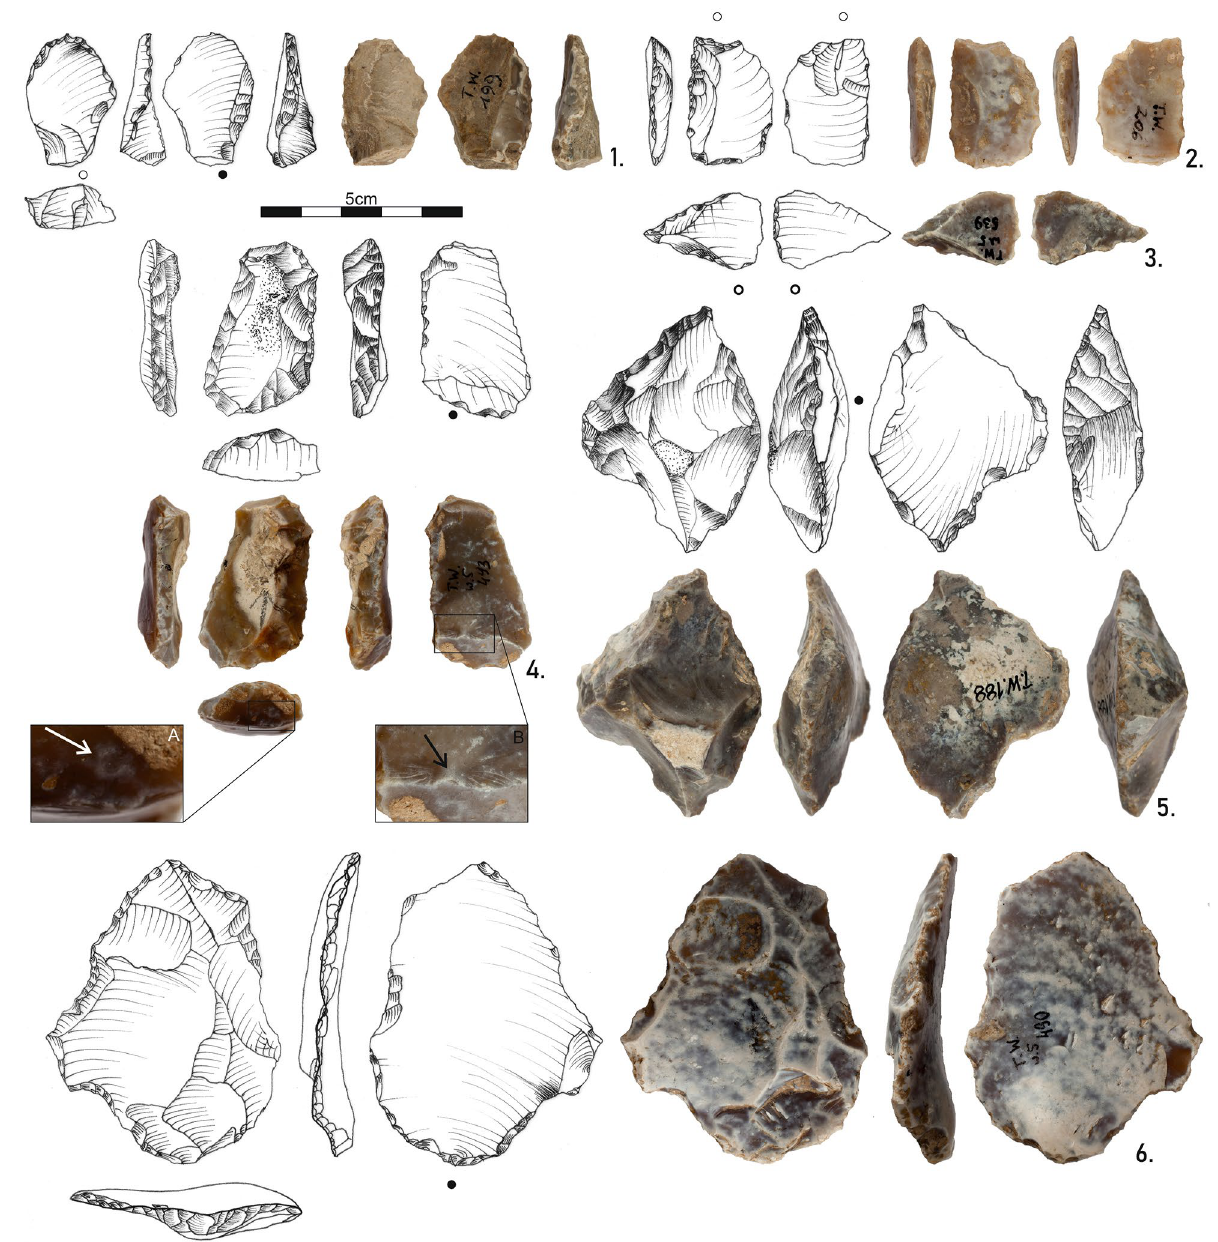
Figure 6. Lithic tools from Tunel Wielki Cave. 1. Kombewa flake; 2. Kombewa flake with a retouched edge; 3. Broken Kombewa flake; 4. Longitudinally retouched flake; 5. Transversally retouched flake; 6. Flake with heavily postdepositionally damaged edges. Its big size, longitudinal curvature, massive bulb and equal thickness throughout its whole length indicate the use of free-hand technology; A. Hertzian cone of the unsuccessful flake detachments; B. Protruding point of percussion on the ventral side of the right. Three Kombewa flakes were identified in the assemblage (Fig. 6). Flakes have big convex or flat butts, either prepared with a single removal or left cortical without preparation. The point of percussion can be seen on the ventral side. In seven cases, it has a form of half of the Hertzian cone (Fig. 6:4). Bulbar scars were identified in 8 cases. Hertzian cones of the unsuccessful percussion attempts can also be identified on the butts (Fig. 6:4). Besides the protruding fracture point, flakes have no bulbs (except two artefacts with big bulbs). Intensively curved ripples or even compression rings can be observed on the ventral sides of the flakes. Radial fissures are well visible, especially near the point of percussion. A specific feature of a split of the ventral surface in its distal part can be observed in several pieces. The technological features of the debitage fit the knapping scheme identified in cores. Taking into consid- eration the following features, we assume that one of the knapping technologies used was the bipolar-on-anvil technique (Fig. 7):